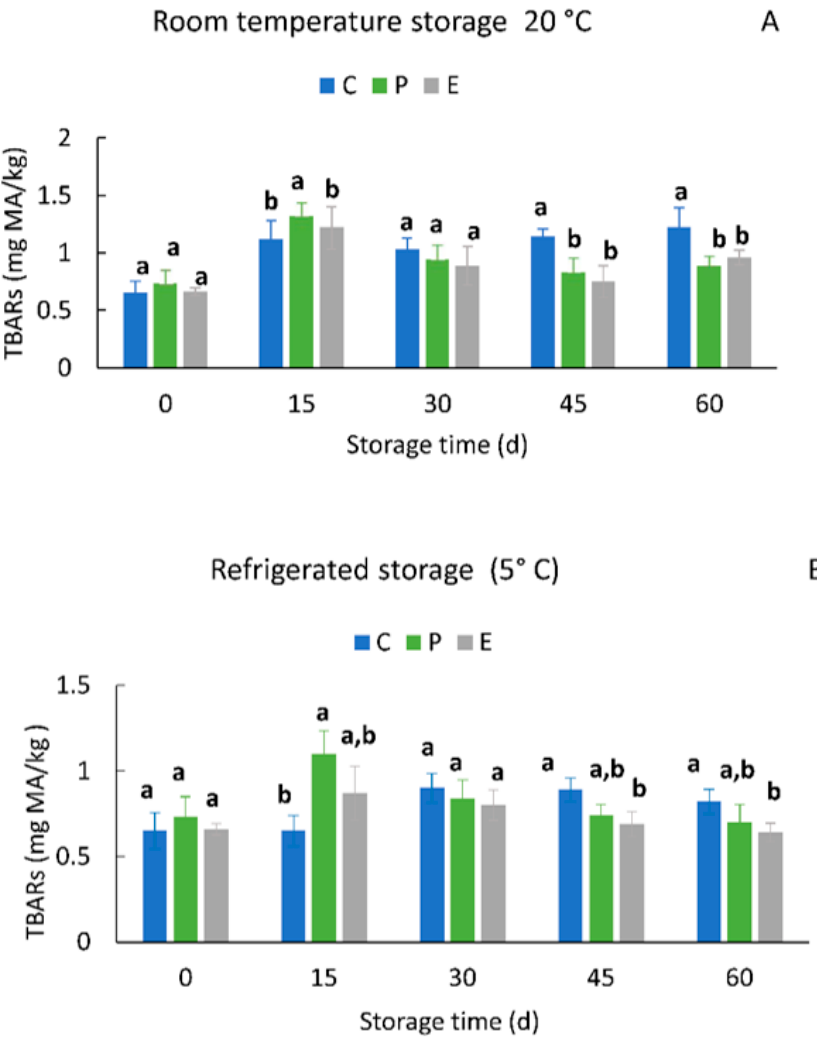
Figure 8. ( A ) : TBARs values (means ± standard deviations) during 60 d of room temperature storage (20 °C) of Salamines Criollos formulated with microencapsulated L. plantarum BFL (E) and free L. plantarum BFL (P). ( B ) : TBARs values (means ± standard deviations) during 60 d of refrigerated storage (5 °C) of Salamines Criollos formulated with microencapsulated L. plantarum BFL (E) and free L. plantarum BFL (P). The different letters indicate significant differences between treatments on the same day under the same storage temperature.